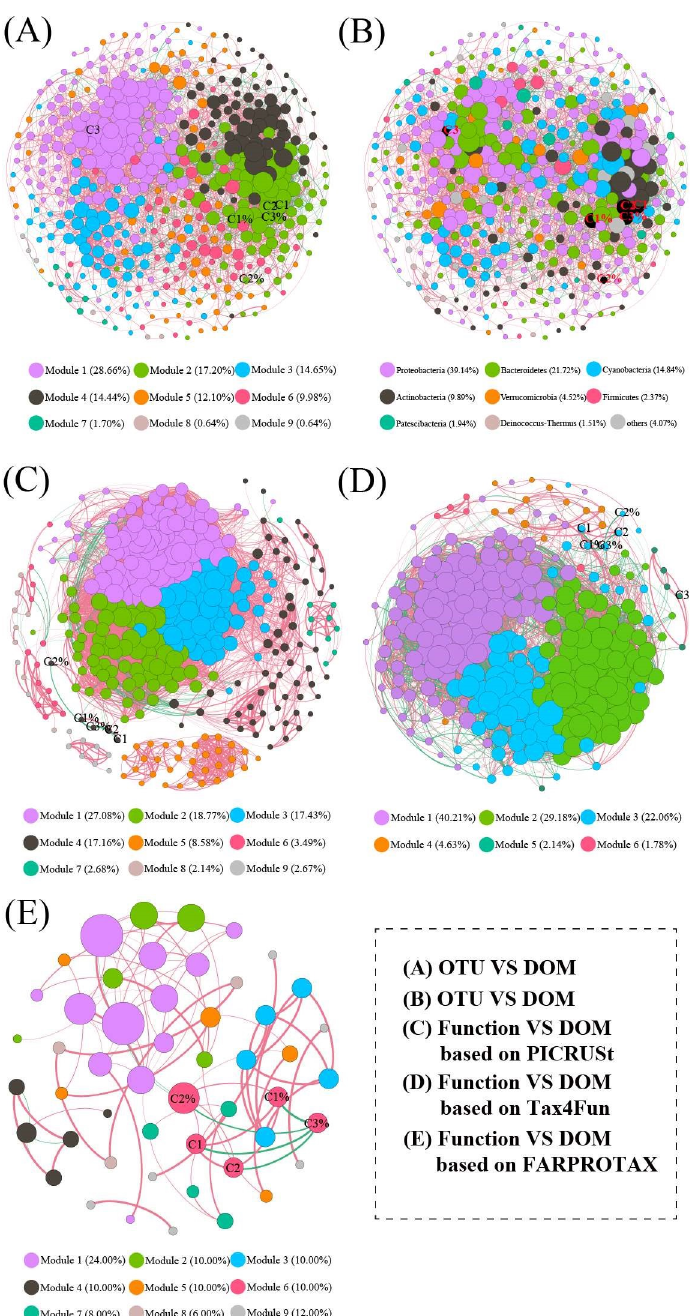
Figure 7. Network visualizes the OTU-DOM and functional community-DOM interactions in Baiyangdian Lake. Positive correlations were displayed in red and negative correlations were displayed in green. The nodes were coloured according to different types of modularity classes. The size of each node is proportional to the degree. (Spearman (cid:48) s | r |> 0.6, p < 0.05). ( A ) microbial network analysis based on OTU vs DOM (module level); ( B ) microbial network analysis based on OTU vs DOM (phylum level); ( C ) microbial network analysis based on function vs DOM (PICRUSt2); ( D ) microbial network analysis based on function vs DOM (Tax4Fun); ( E ) microbial network analysis based on function vs DOM